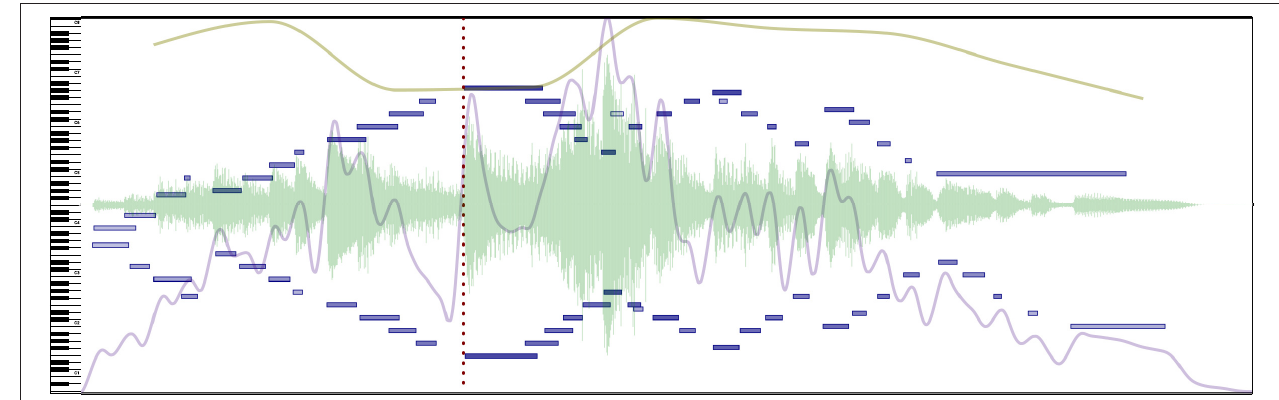
FIGURE 7 | Stress is marked by a comment (red dotted line) at the pinnacle of the progression in this excerpt of Beethoven’s Variation No. III from 32 Variations in C minor. See Supplementary Video 5 in the Supplementary Materials to hear the music presented in this Figure.